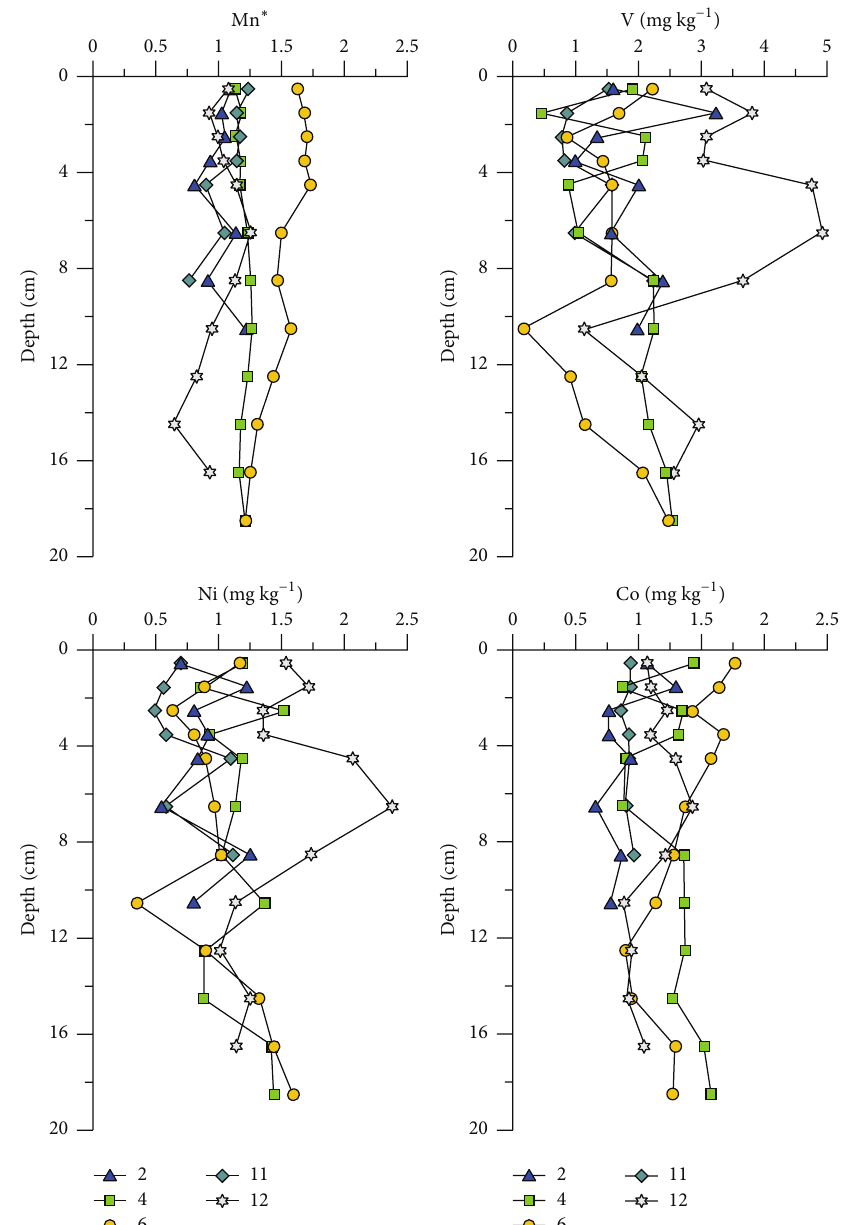
Figure 4: Depth profiles of Mn ∗ and concentrations of V, Ni, and Co (all expressed in mg kg −1 ) for lake Specchio di Venere sediment